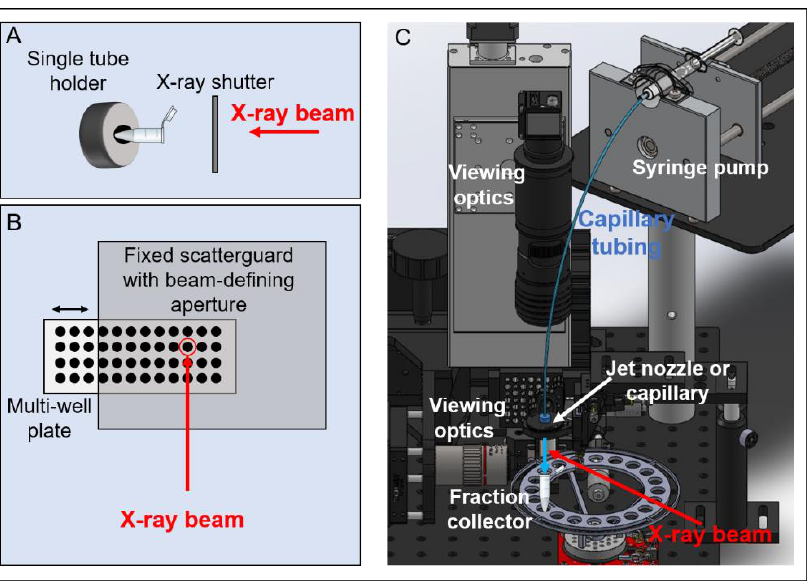
Figure 3. Overview of the synchrotron X-ray HRPF experiment sample delivery modes: ( A ) Single- tube exposure is defined by X-ray shutter opening/closing. ( B ) Well-plate velocity determines X-ray exposure times. For these methods of exposure, scavenging buffer is added post-exposure after tubes or plate is removed from the endstation. ( C ) Syringe pump delivers sample through a capillary or jet nozzle into a fraction collector containing scavenging buffer; velocity of sample and beam size determine exposure times. Other components of a typical XFMS experiment include pin diodes for flux monitoring, cooling blocks, optics for sample viewing, and beam-defining apertures and scatter guards.